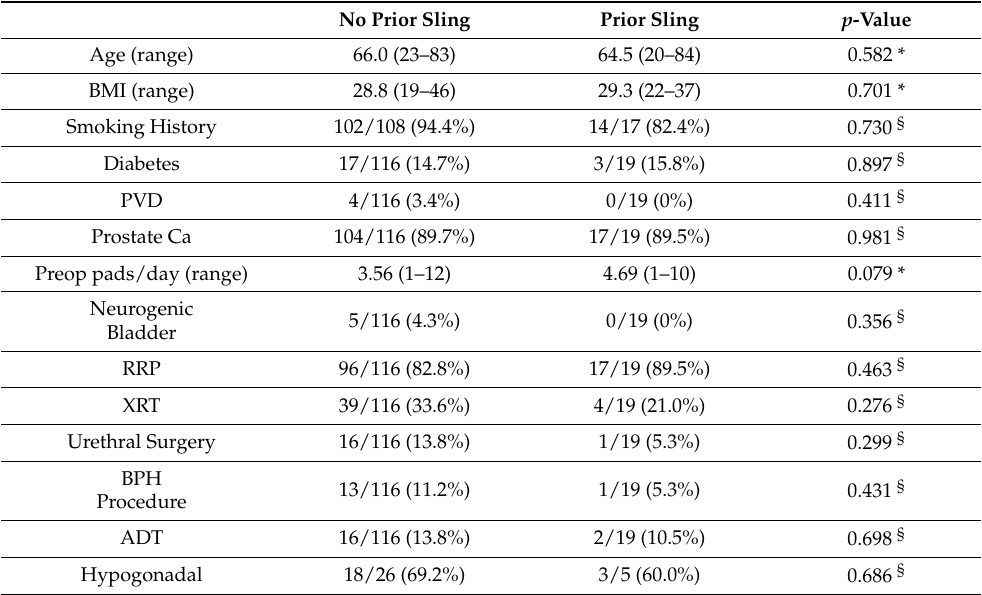
Table 1. Patient